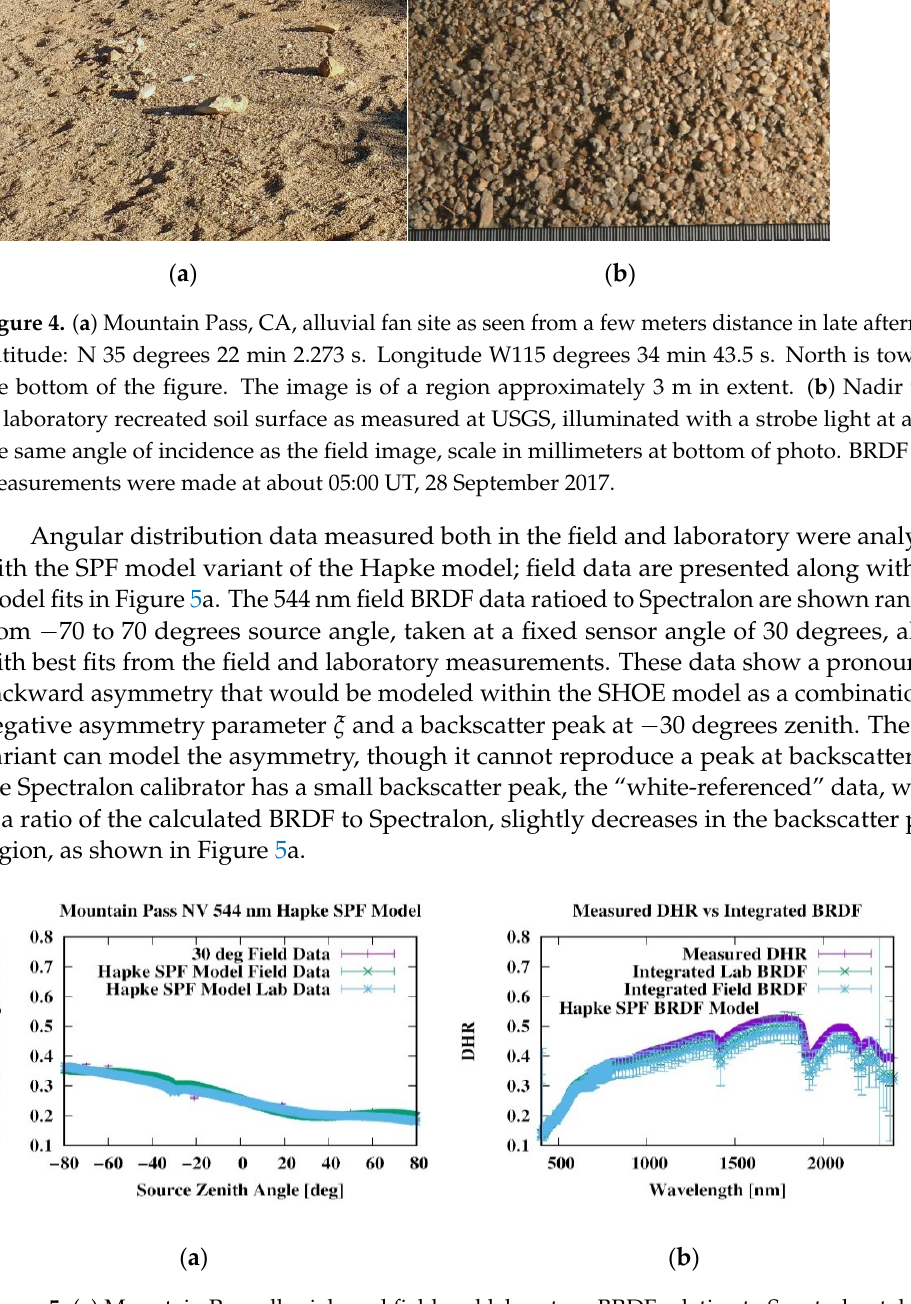
Figure 5. ( a ) Mountain Pass alluvial sand field and laboratory BRDF relative to Spectralon taken at 30 degrees source Zenith for 544 nm data with best fits using the SPF variant of Hapke’s BRDF model. ( b ) integrated BRDF over the hemisphere (right) for both field and laboratory measurement for the Mountain Pass site. Measured laboratory DHR is shown to be consistent with the integrated BRDF values obtained from either the field or laboratory data.